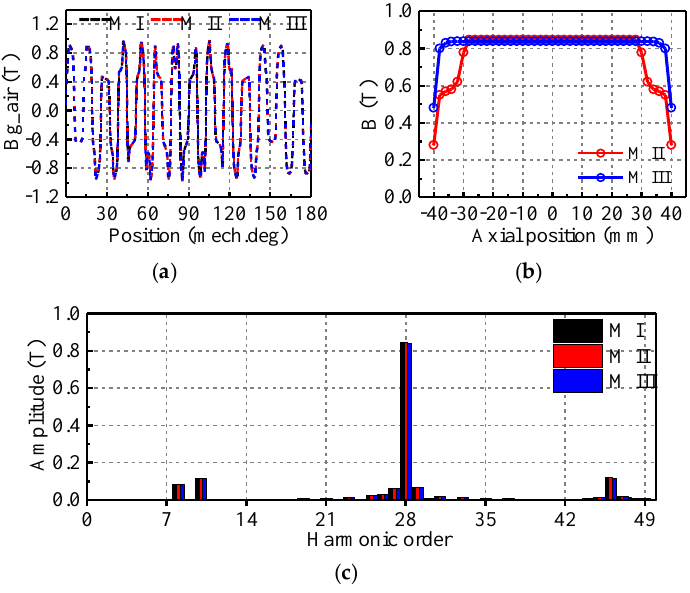
Figure 5. No-load air-gap magnetic flux density. ( a ) 0 mm waveform. ( b ) Air-gap flux density versus axial position. ( c ) 0 mm harmonic